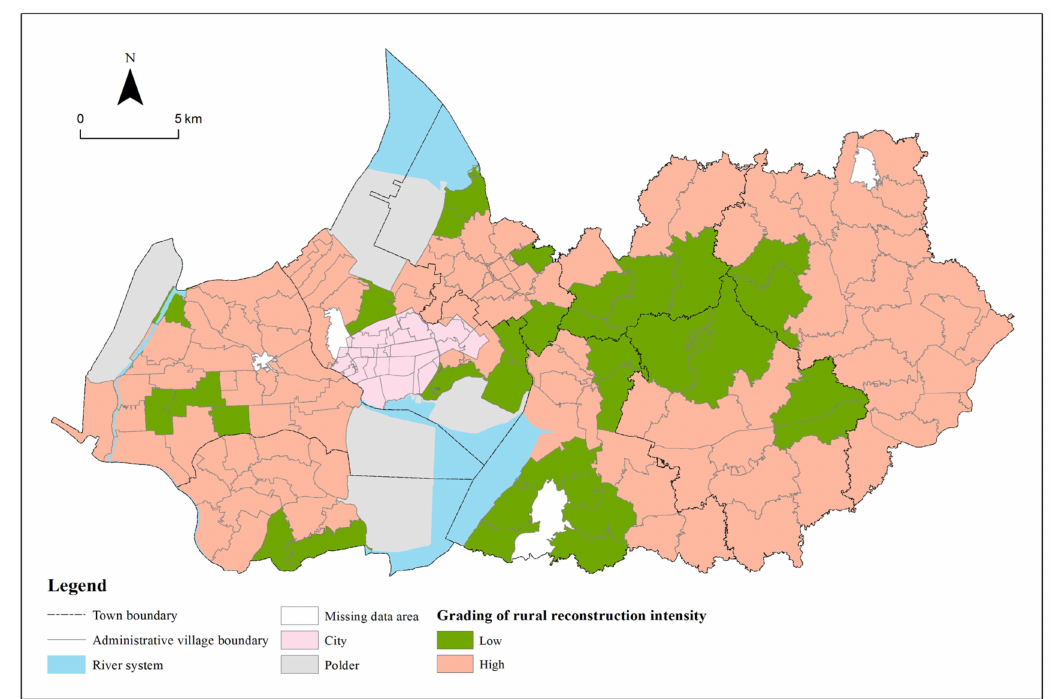
Figure 6. Distribution of reconstruction intensity of administrative villages in Gaochun